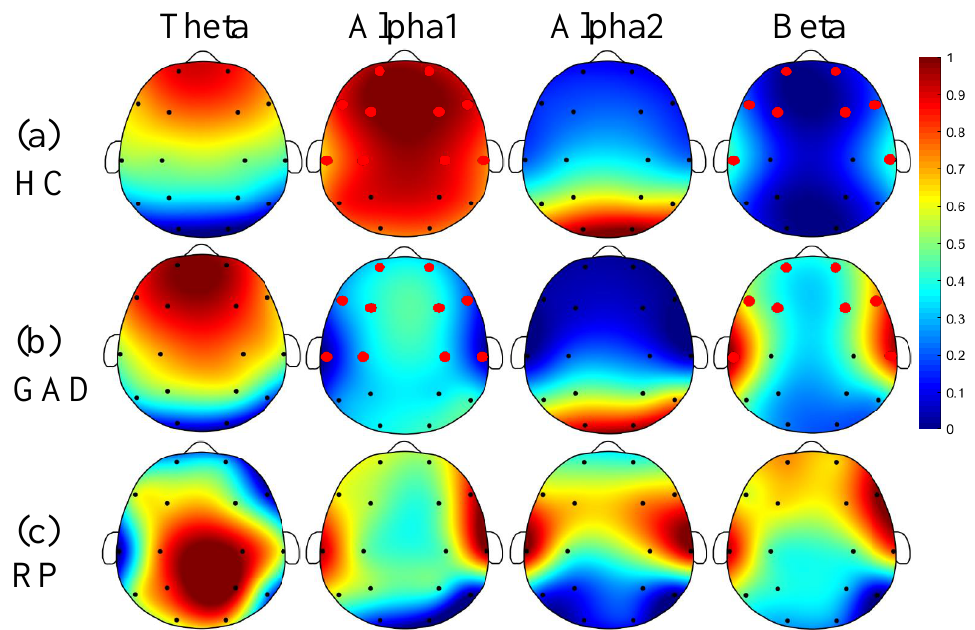
Figure 1. Brain topography of the PSD for the four EEG rhythms. Each value is the average of all subjects. The relative powers of HC ( a ) and GAD ( b ) have been normalized between 0 and 1 for the theta, alpha1, alpha2, and beta rhythms for the sake of better visualization, so they share the same color bar. The red dots represent these EEG channels have significant differences ( p < 0.05). The subgraphs of ( c ) are the relative PSD (RP: |PSD GAD -PSD HC |/PSD HC ) of GAD relative to HC for the four rhythms.